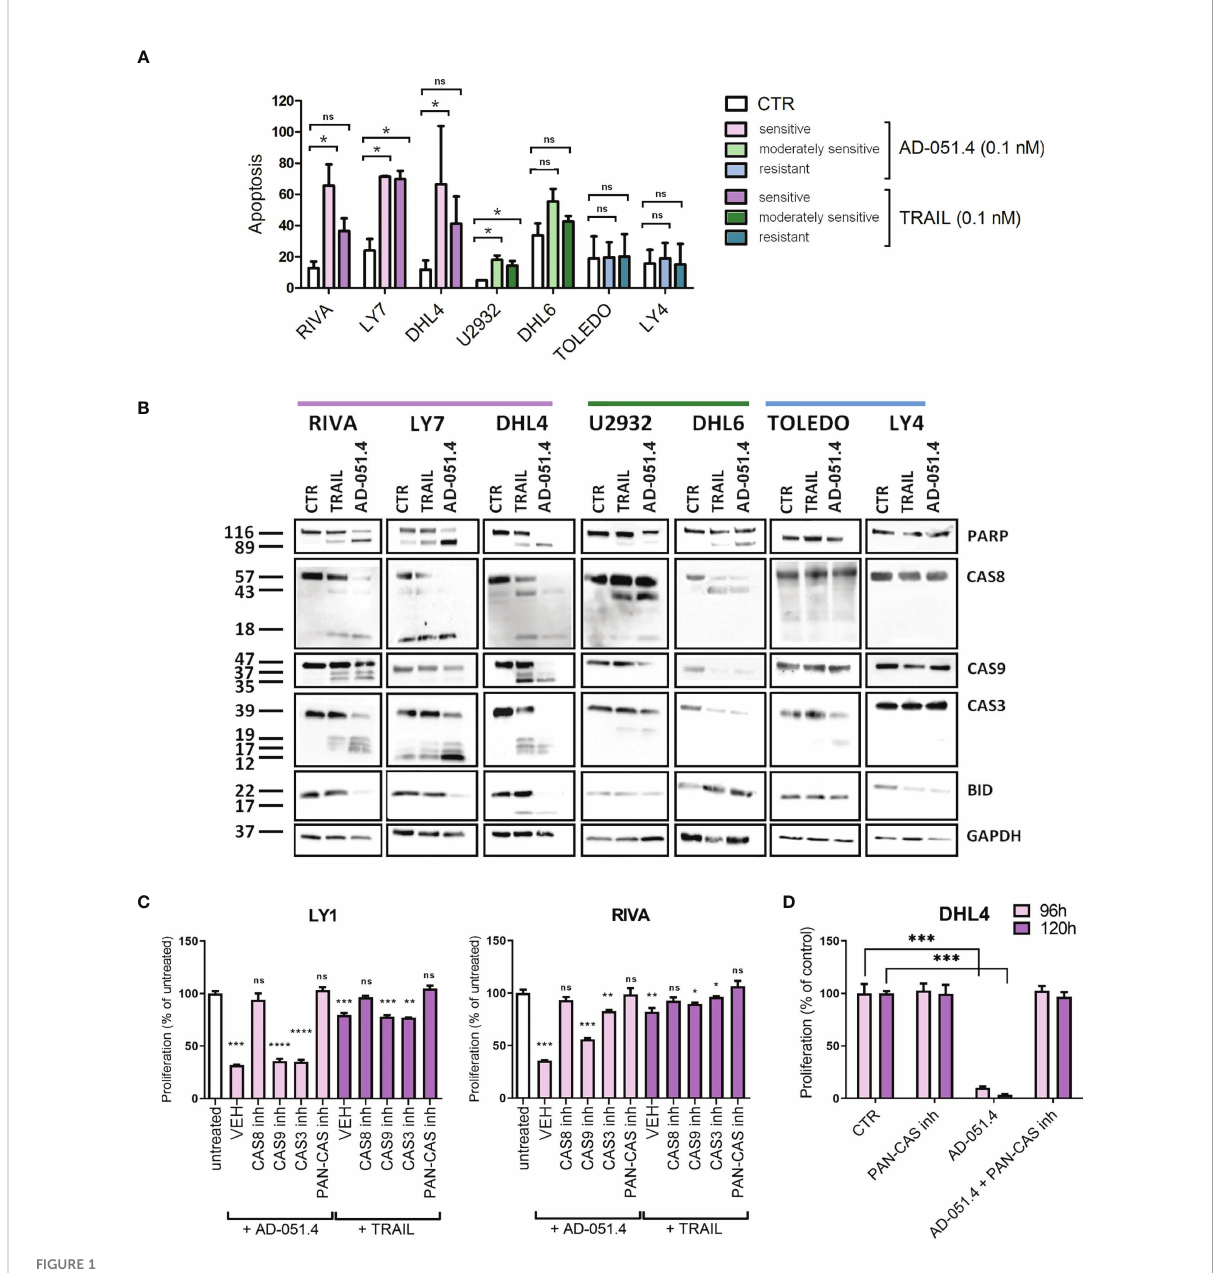
FIGURE 1 AD-O51.4 induces apoptosis in DLBCL cells. (A) Fraction of apoptotic cells in DLBCL cell lines incubated with 0.1 nM AD-O51.4, 0.1 nM TRAIL or PBS (control, CTR) for 24h. Early- and late – apoptotic cells are pooled together (Annexin V+/PI- and AnnexinV+/PI+, respectively). Corresponding dot-plots of a representative experiment are shown in Supplemental Figure 3. Experiments were performed in 2 replicates. Error bars indicate standard deviations (SD). Differences between number in apoptotic cells are indicated (Student t -test, *p-value<0.05, **p-value<0.005, ***p-value<0.001, ****p-value<0.0005, ns – not signi fi cant. (B) Processing of PARP, Caspase 8, 9, 3 and BID in DLBCL cell lines incubated with AD-O51.4 or TRAIL. Cells were incubated with the AD-O51.4 or TRAIL for 6h, lysed and processing/cleavage of indicated proteins was evaluated using immunoblotting. GAPDH served as a loading control. Cleavage of the protein is manifested either by appearance of its cleaved (lighter) form (e.g. PARP, CASP3, CASP8), or by disappearance of a full-length protein (e.g BID). (C) Caspase inhibition blocks induction of apoptosis in AD-O51.4-sensitive DLBCL cells. LY1 or RIVA cells were pre-incubated with caspase 3, 8 9, pan-caspase inhibitor or DMSO (vehicle, VEH) for 1 h, then with 0.1 nM AD-O51.4, 0.1 nM TRAIL for subsequent 48 h. Viability was assessed with an MTS assay. Bars represent the average of three independent experiments, error bars represent standard deviations, statistical differences are indicated as in panel A. (D) Prolonged incubation with AD-O51.4 does not induce caspase-independent cell death in DLBCL cells. DHL4 cells were pretreated with Z-VAD-FMK pan-caspase inhibitor (20 m M, 1 h), and then incubated with AD-O51.4 for 96-120h. Cell viability was evaluated with an MTS assay. Bars represent the average of three independent experiments, error bars represent standard deviations, statistical differences are indicated as in panel (A) Results were normalized to untreated cells (viability